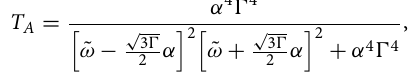
Figure 3. Density plot of differential conductance vs r and eV in the noninteracting case, when ǫ d 0.1 Ŵ and 0.1 Ŵ ( b ) Closeup of the central peak in the figure ( a ), in the applied applied bias range between ( a ) − 0.001 Ŵ and 0.001 Ŵ bias range between −